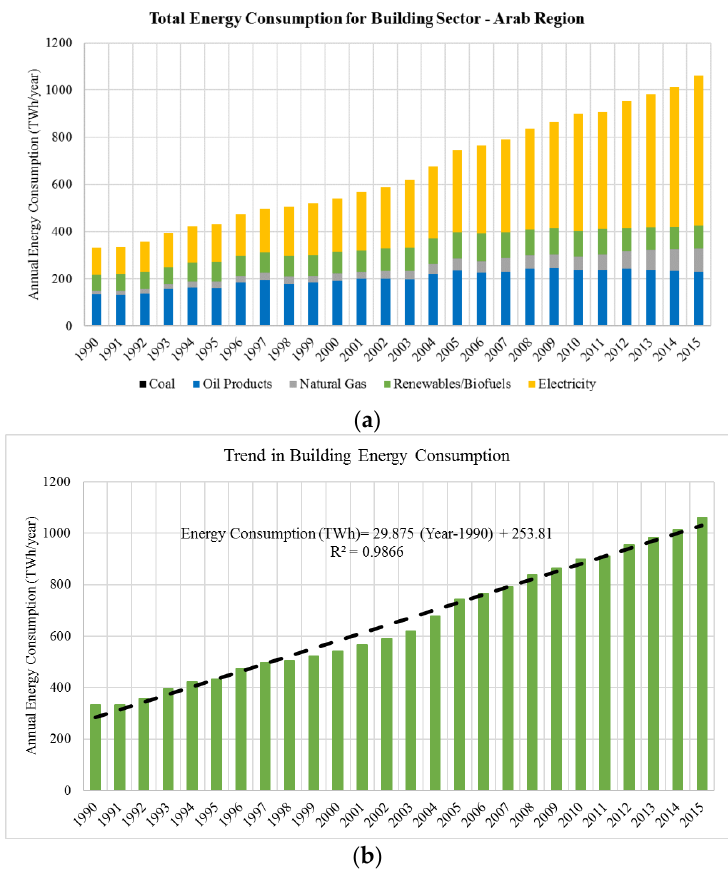
Figure 8. Total annual energy use of the building sector in the Arab region between 1990 and 2015. ( a ) Energy mix; ( b ) trend between energy consumption and year.